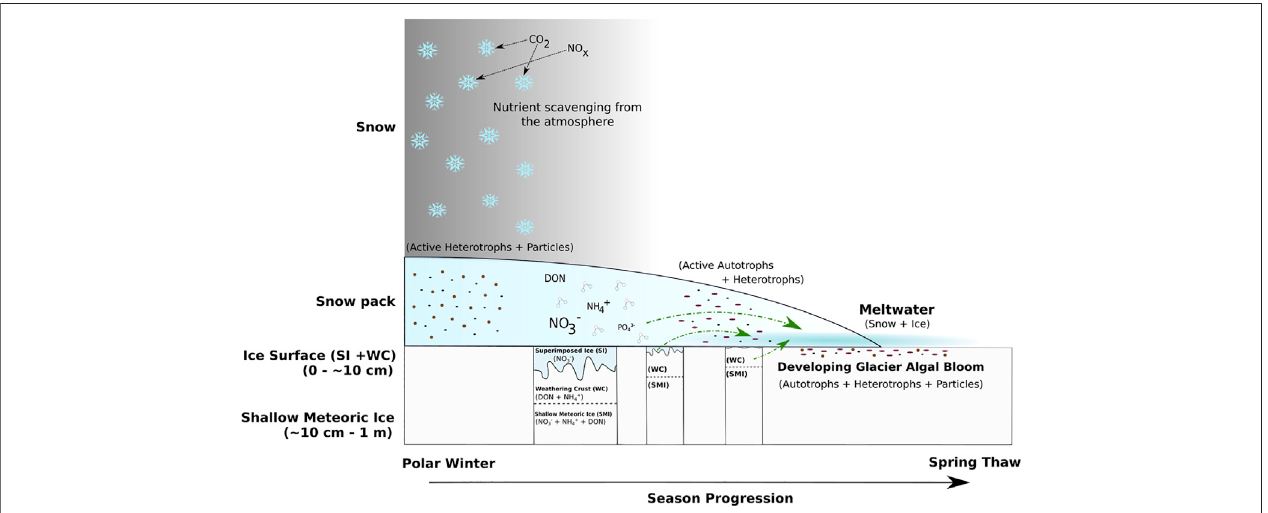
FIGURE 8 | Conceptual diagram of the transition from polar winter to spring thaw in the supraglacial environment of the GrIS Dark Zone. Green lines represent nutrient inputs to surface ice environments during the spring thaw. Active microbial communities represent potential in fl uencers on nutrient concentration and phase released by the different